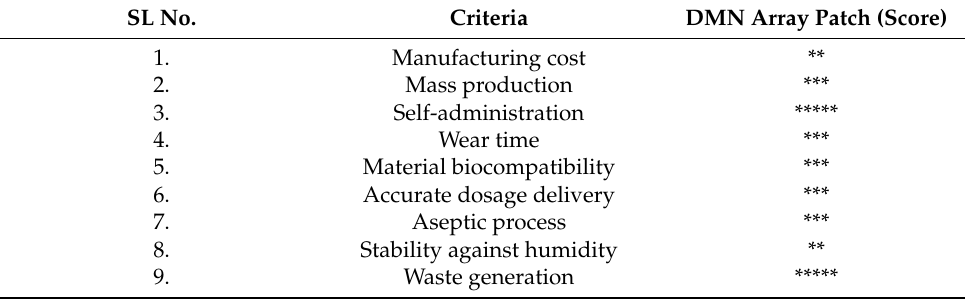
Table 5. Extent of utility of DMN in vaccination. SL